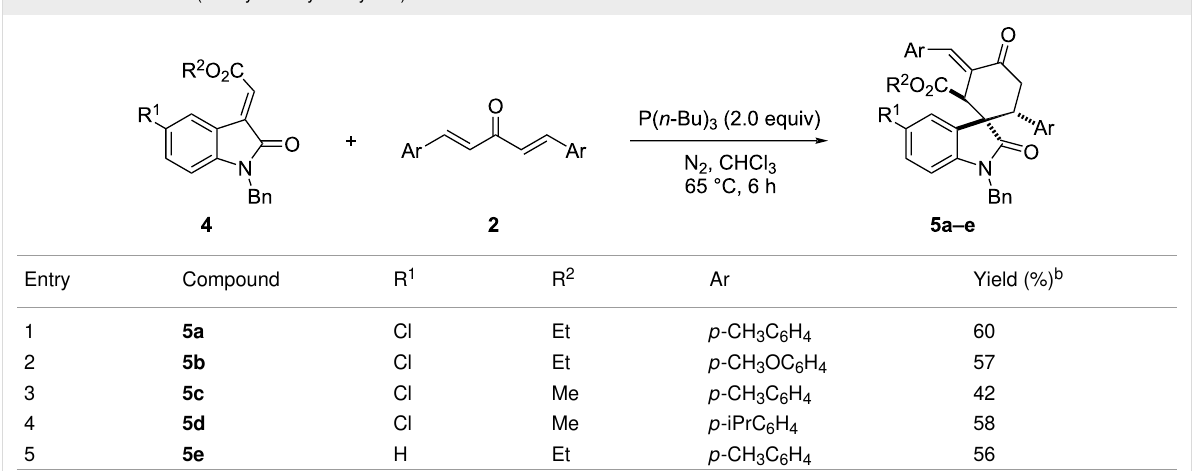
Table 3: Reaction of 3-(ethoxycarbonylmethylene)oxindoles and bis-chalcones.